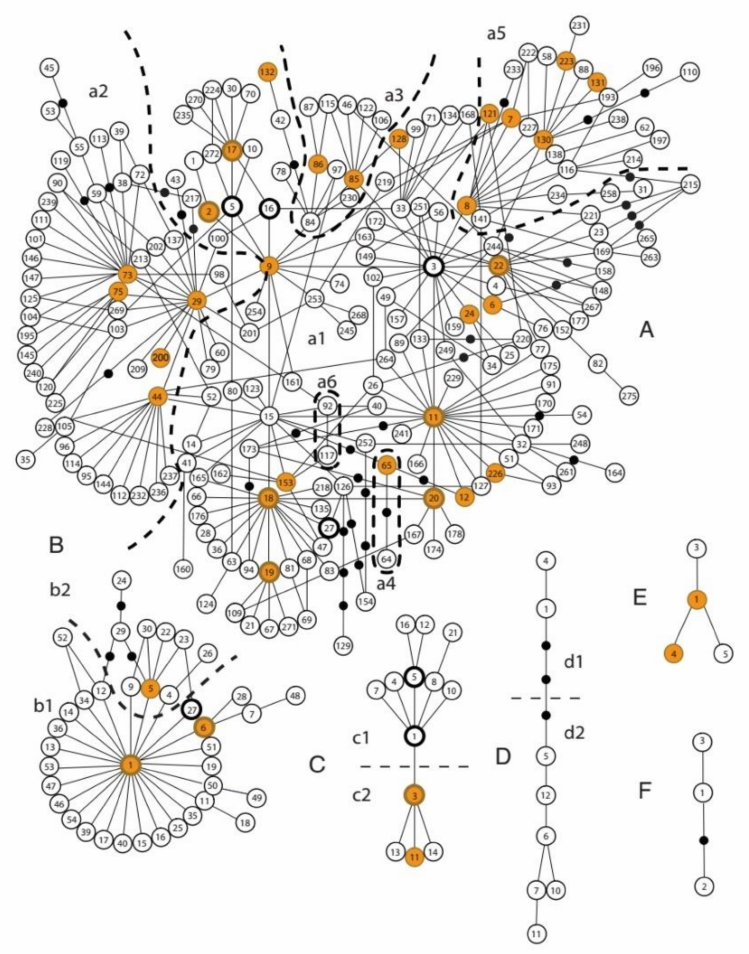
Figure 2. Minimum spanning networks showing Vietnam village dog haplotypes (yellow-filled circles) in the worldwide dog haplotypes (blank circles). The haplogroups A, B, C, D, E, and F are represented by the letters A, B, C, D, E, and F,